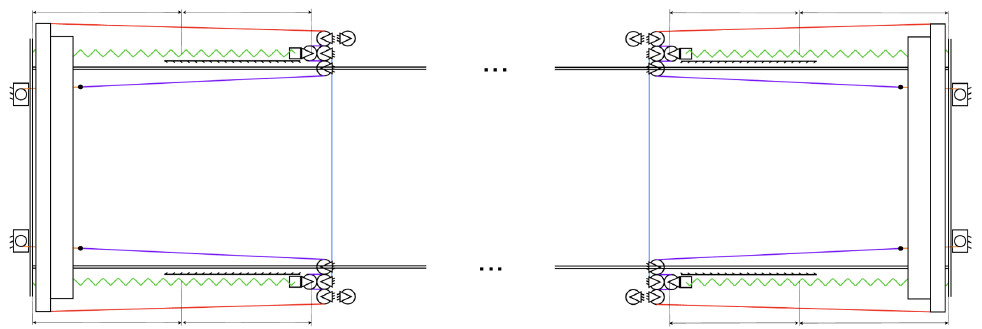
Figure 6. The architecture of an ElektRail equipped with double BLLS acceleration/deceleration sections on the left- and right-hand sides of the figure. (A part of the rail length in between is not